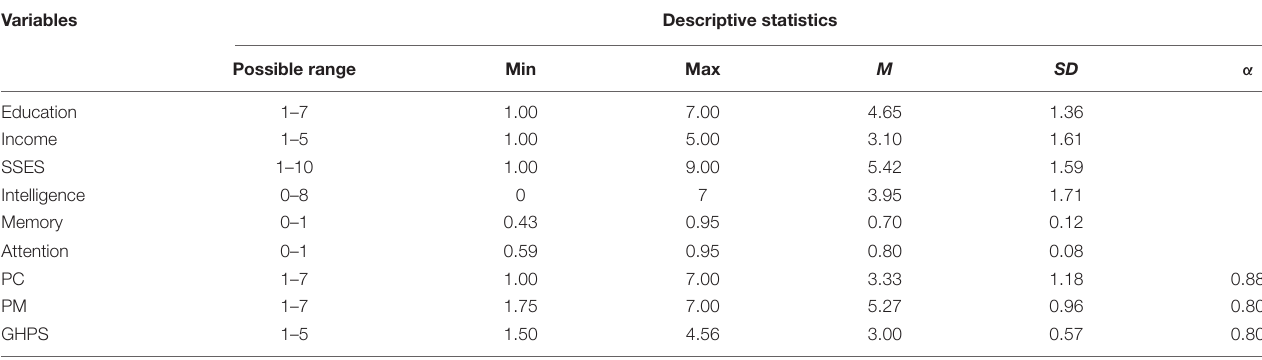
TABLE 1 | Descriptive statistics ( N = 198).